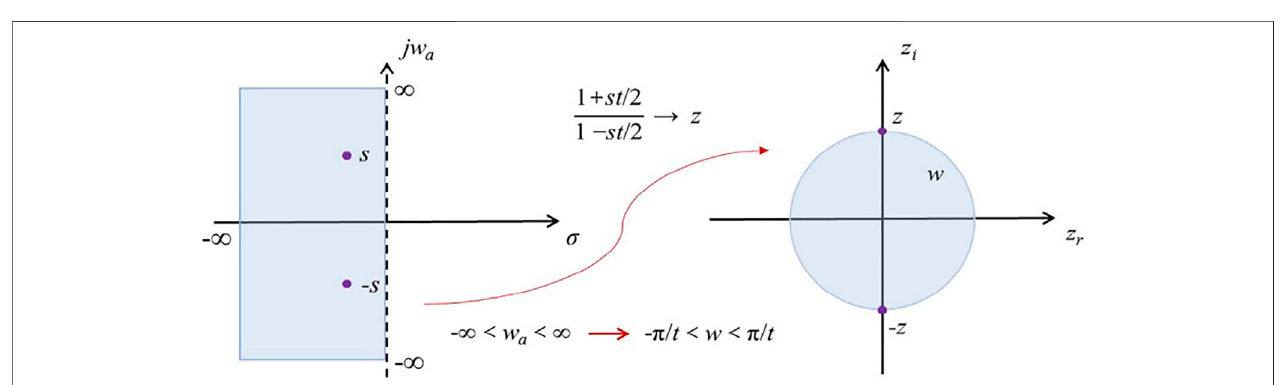
FIGURE 3 | Illustration of the bilinear transformation.